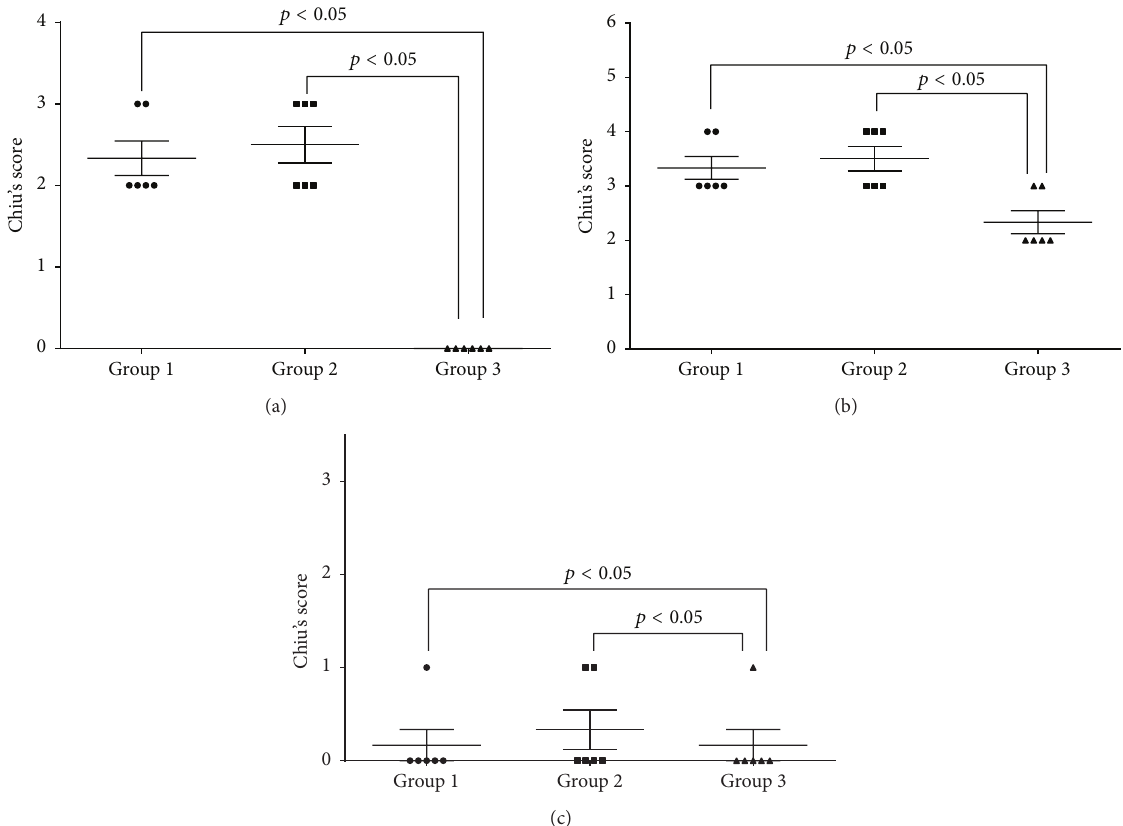
Figure 2: Intestinal injury scores. (a) at the end of the preservation; (b) 1h after ischemia-reperfusion; (c) day 7 after transplantation.